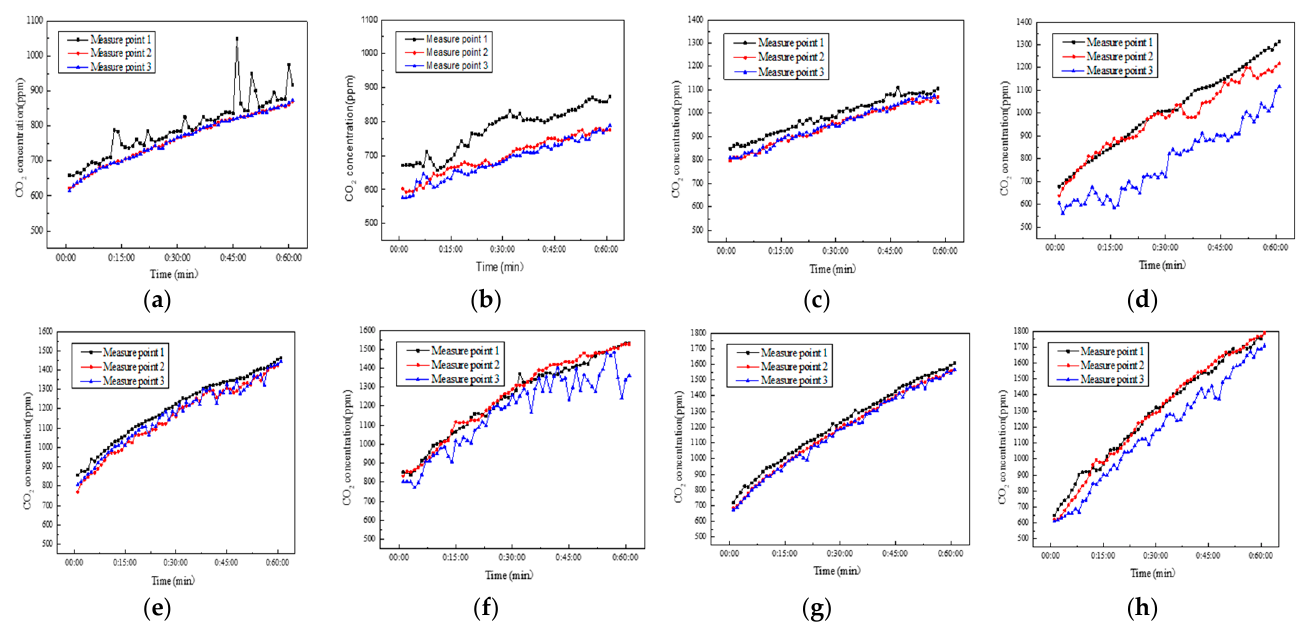
Figure 4. CO 2 concentrations in different points in different cases. ( a ) Case 1, ( b ) case 2, ( c ) case 3, ( d ) case 4, ( e ) case 5, ( f ) case 6, ( g ) case 7, ( h ) c ase 8. ( d ) case 4, ( e ) case 5, ( f ) case 6, ( g ) case 7, ( h ) case